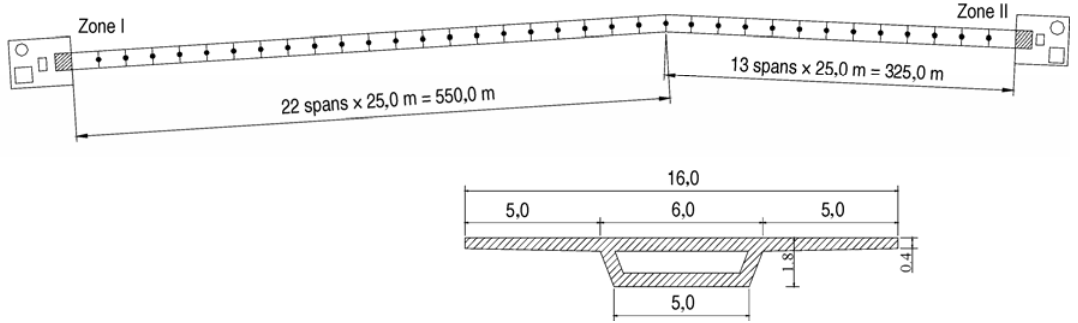
Fig 6 . 15 th May bridge: layout and cross-section